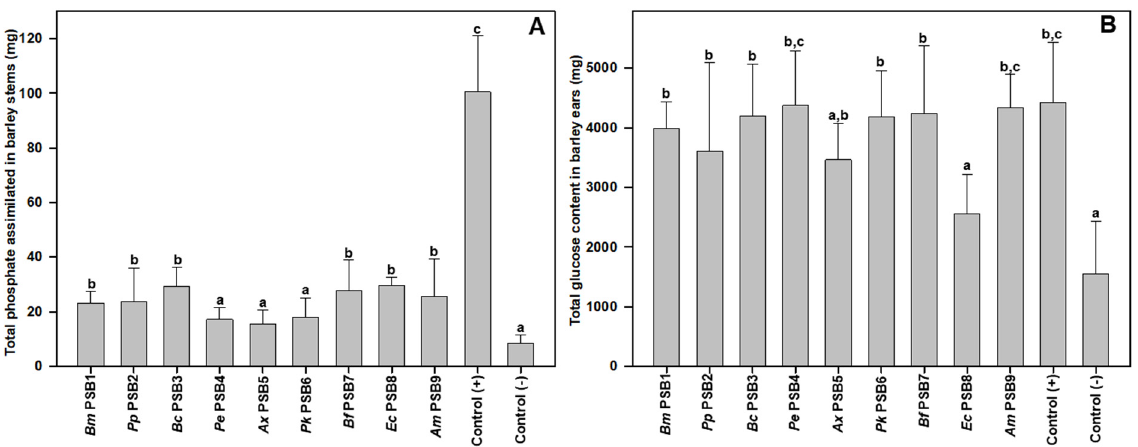
Figure 5. Total phosphate assimilated ( A ), and total glucose content in barley ears ( B ) at the end of the experiment. The data shown correspond to the average of 9 replicates and each replica consisted of 10 plants sown per pot. Bars marked with the same letter are not significantly different ( p ≥ 0.05).